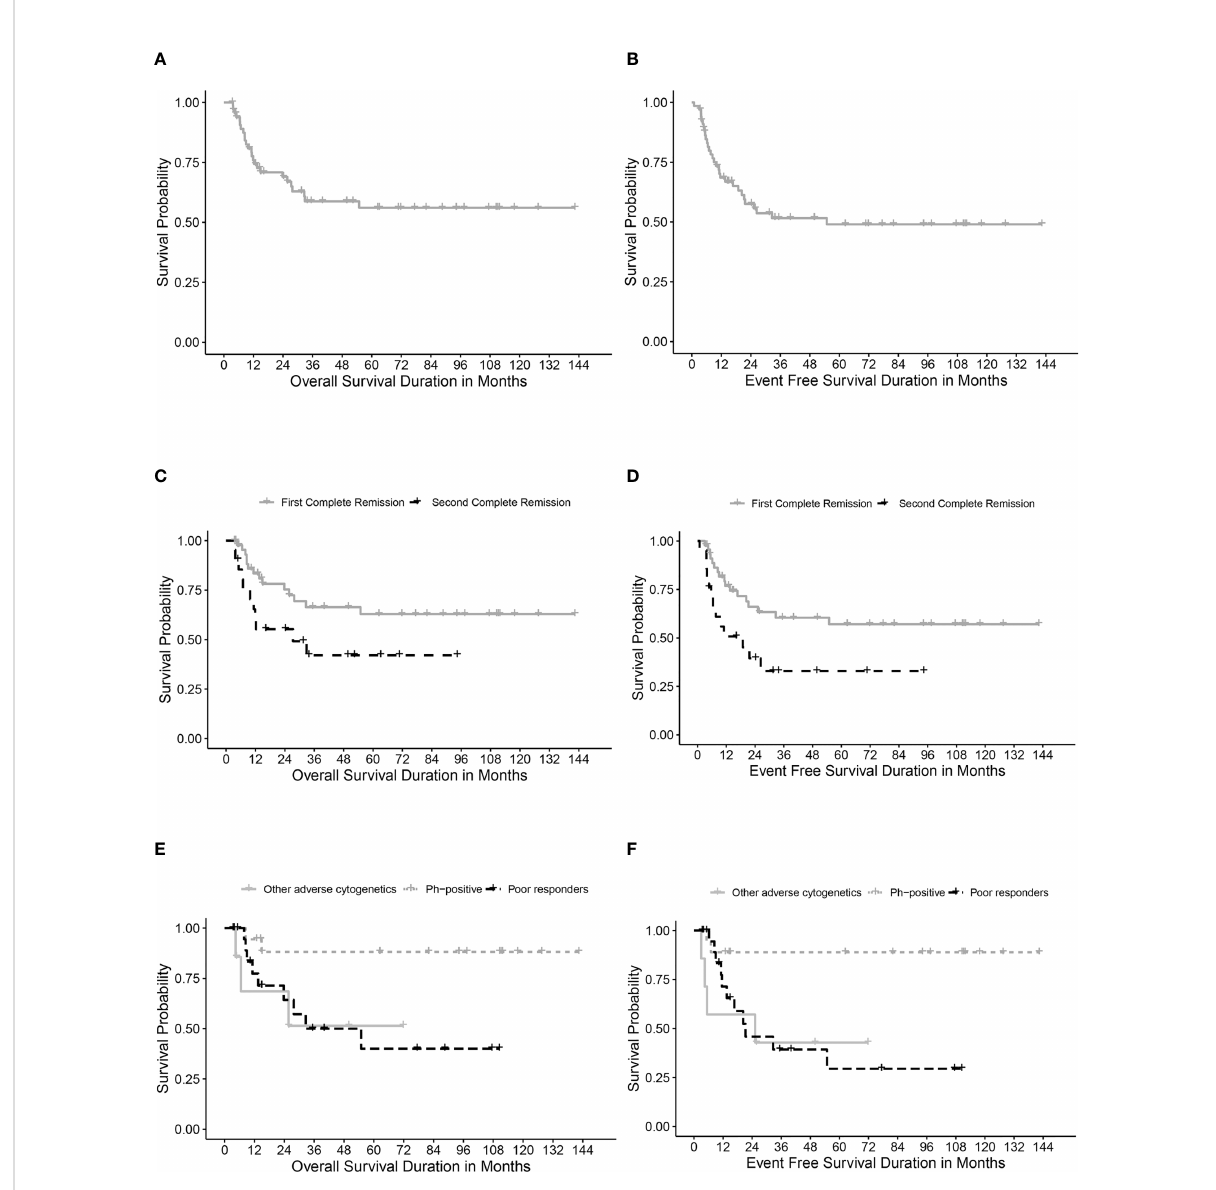
FIGURE 1 Survival rates. (A) Overall survival (OS) for the whole cohort. (B) Event-free survival (EFS) for the whole cohort. (C) OS for transplanted patients in fi rst (CR1) and second (CR2) complete remission. (D) EFS for transplanted patients in fi rst (CR1) and second (CR2) complete remission. (E) OS in relation to high-risk features in CR1 transplants. (F) EFS in relation to high-risk features in CR1